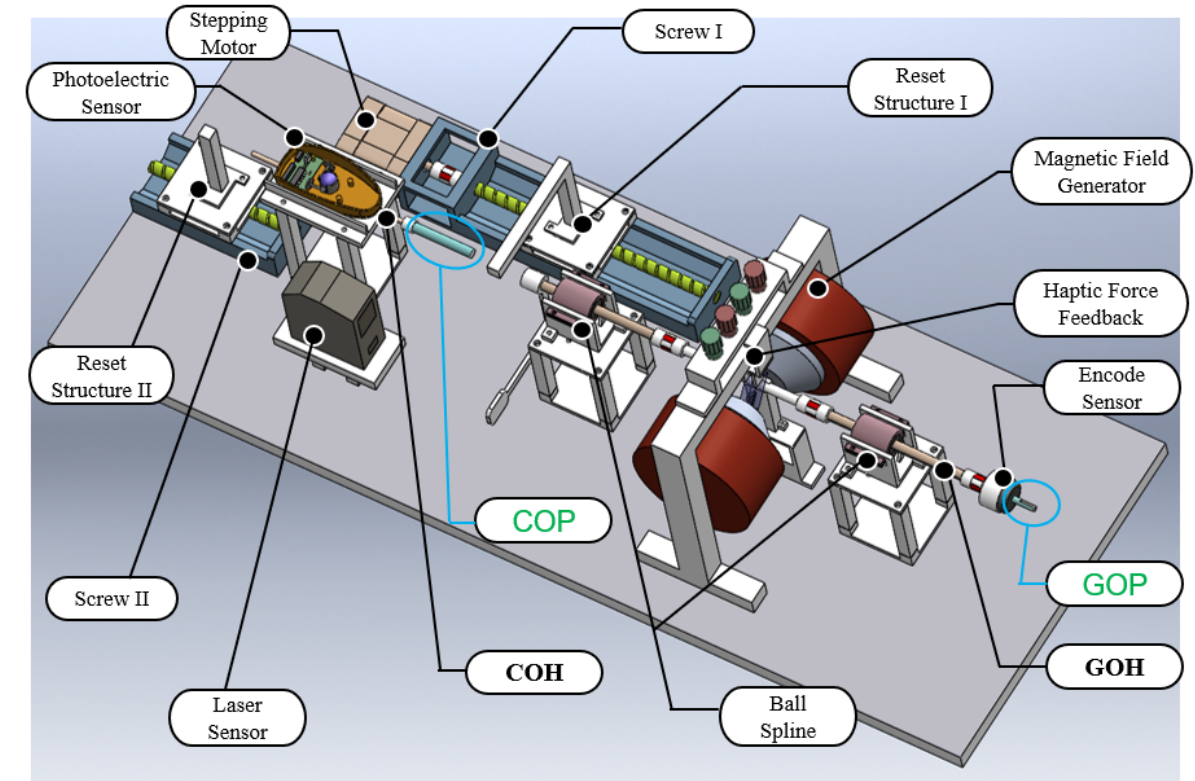
Figure 2. The designed master haptic device. Detailed components of master side: COP (catheter operating position); COH (catheter operating handle); GOP (guidewire operating position); GOH (guidewire operating handle); reset structure II (motor ‐ driven part is omitted).